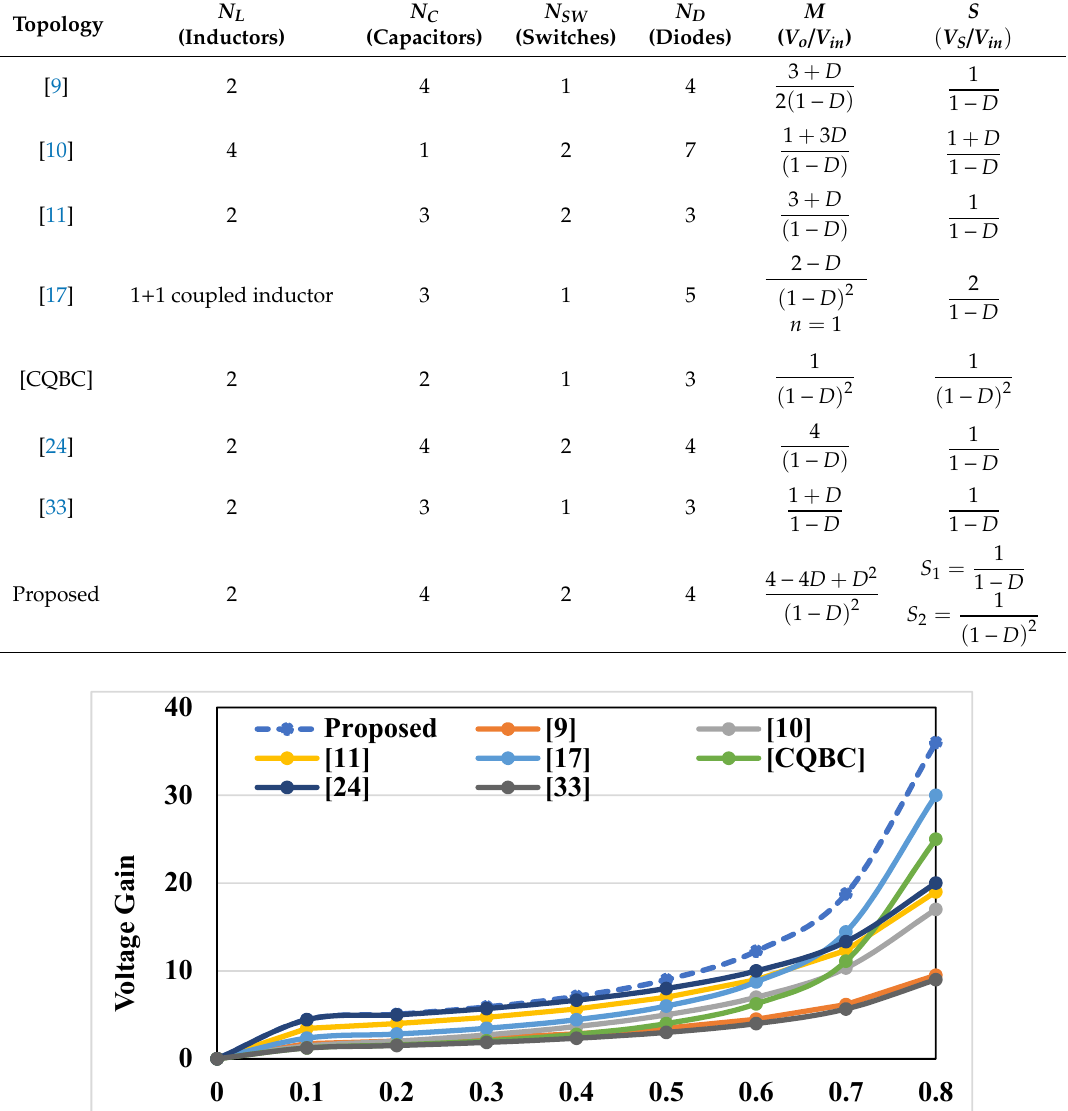
Table 2. Comparison of the proposed topology with other similar topologies.